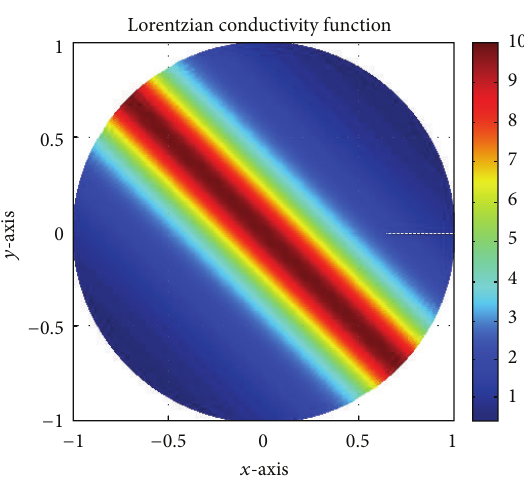
Figure 3: Example of nonseparable-variables conductivity function 𝜎 = 𝑒 𝑥𝑦 .